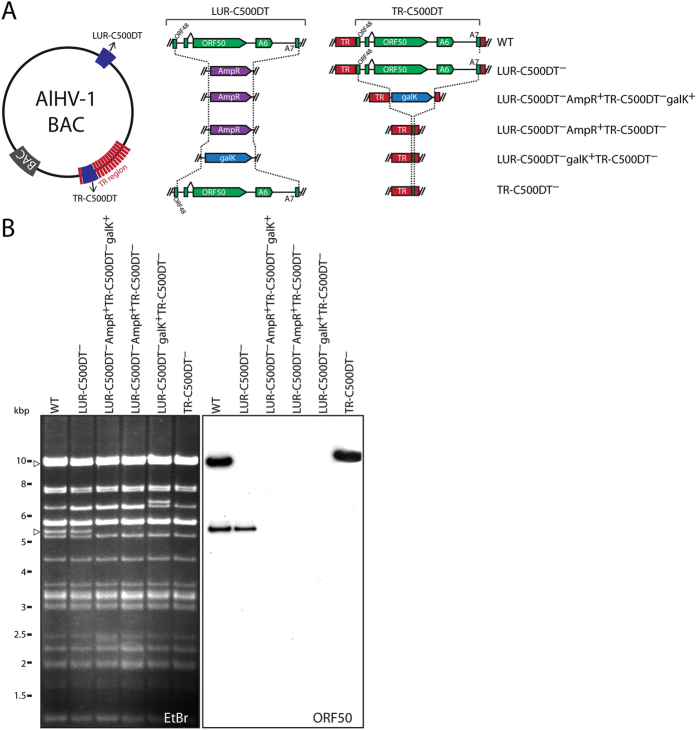
Deletion of TR-C500DT.(A) Outline of the recombineering strategy used to remove C500DT from TR and generate the TR-C500DT− recombinant strain. (B) Southern blotting of the constructs generated. The ORF50 probe was produced by PCR using primers C500-1 and C500-224. EtBr indicates ethidium bromide-stained lanes prior to blotting. The entire gel and blot analysed by Southern blotting are displayed.